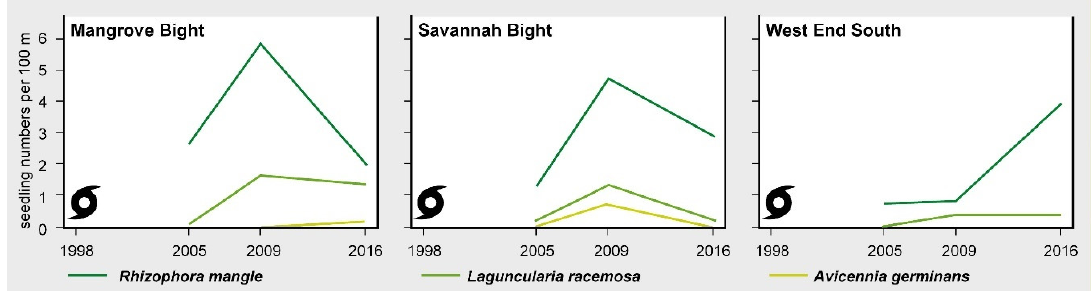
Figure 5. Mean seedling numbers per 100 m of the three mangrove tree species present on Guanaja .